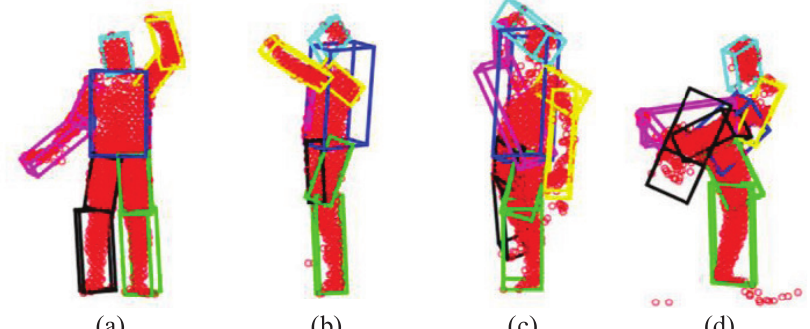
Figure 6. Some examples of segment volume validation: ( a ) a passing case; ( b ) Case I failure (invalid M ); ( c ) Case II failure (invalid M and M ) in a couple of limbs and the 1 1 2 torso; ( d ) Case III failure (invalid M and M in most 1 2